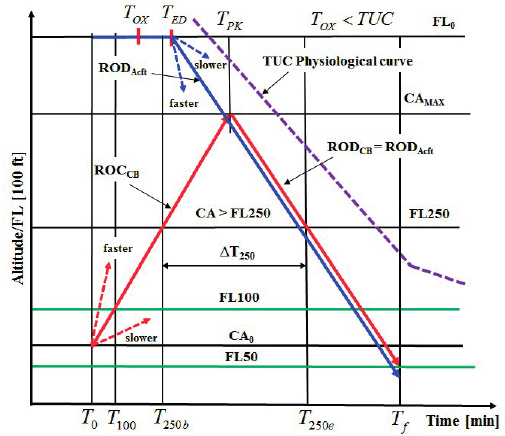
Fig. 2. Simple algebraic CA dynamics versus the ED flight profile. Not to scale